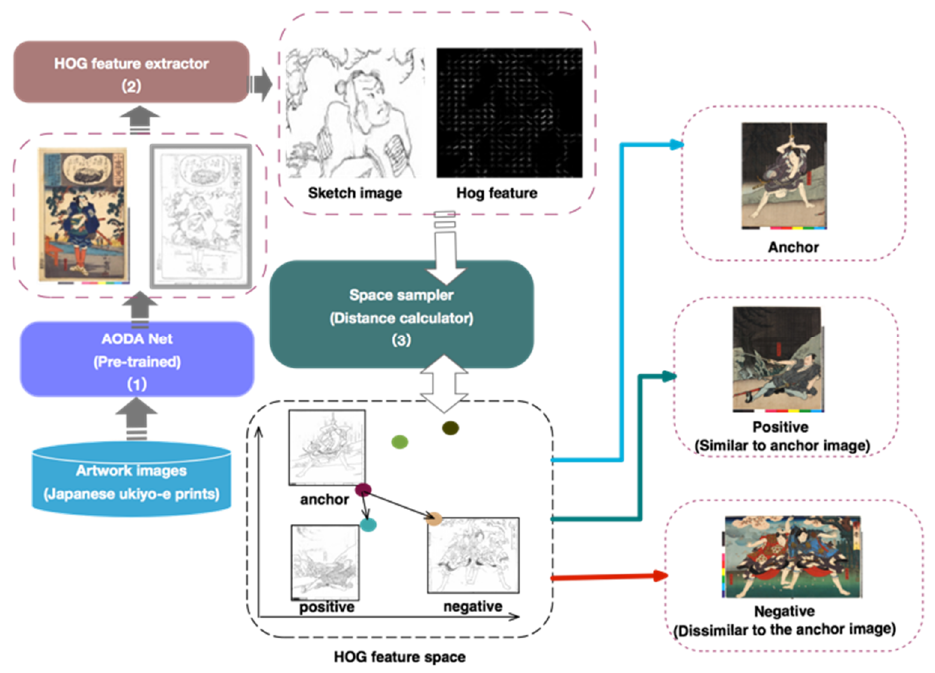
Figure 6. Structure of the space sampler module. ( 1 ) refers to process image sketch extraction, ( 2 ) refers to process HOG feature extraction and ( 3 ) refers to process triplet data sampling.